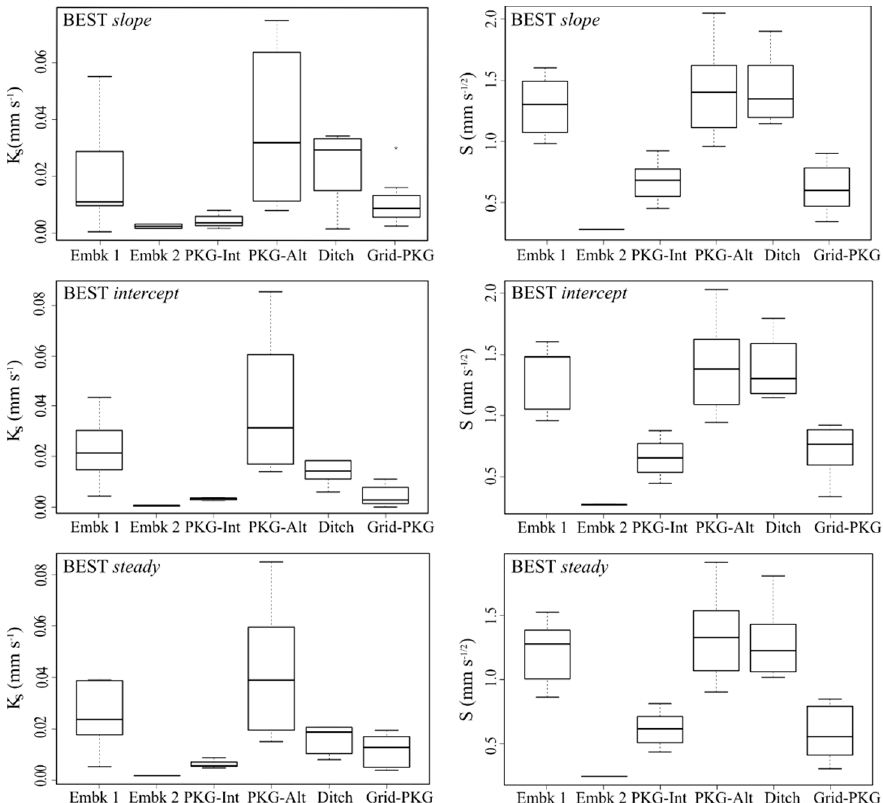
Figure 4. Estimates of K s and S of the studied soils obtained by the three BEST methods.